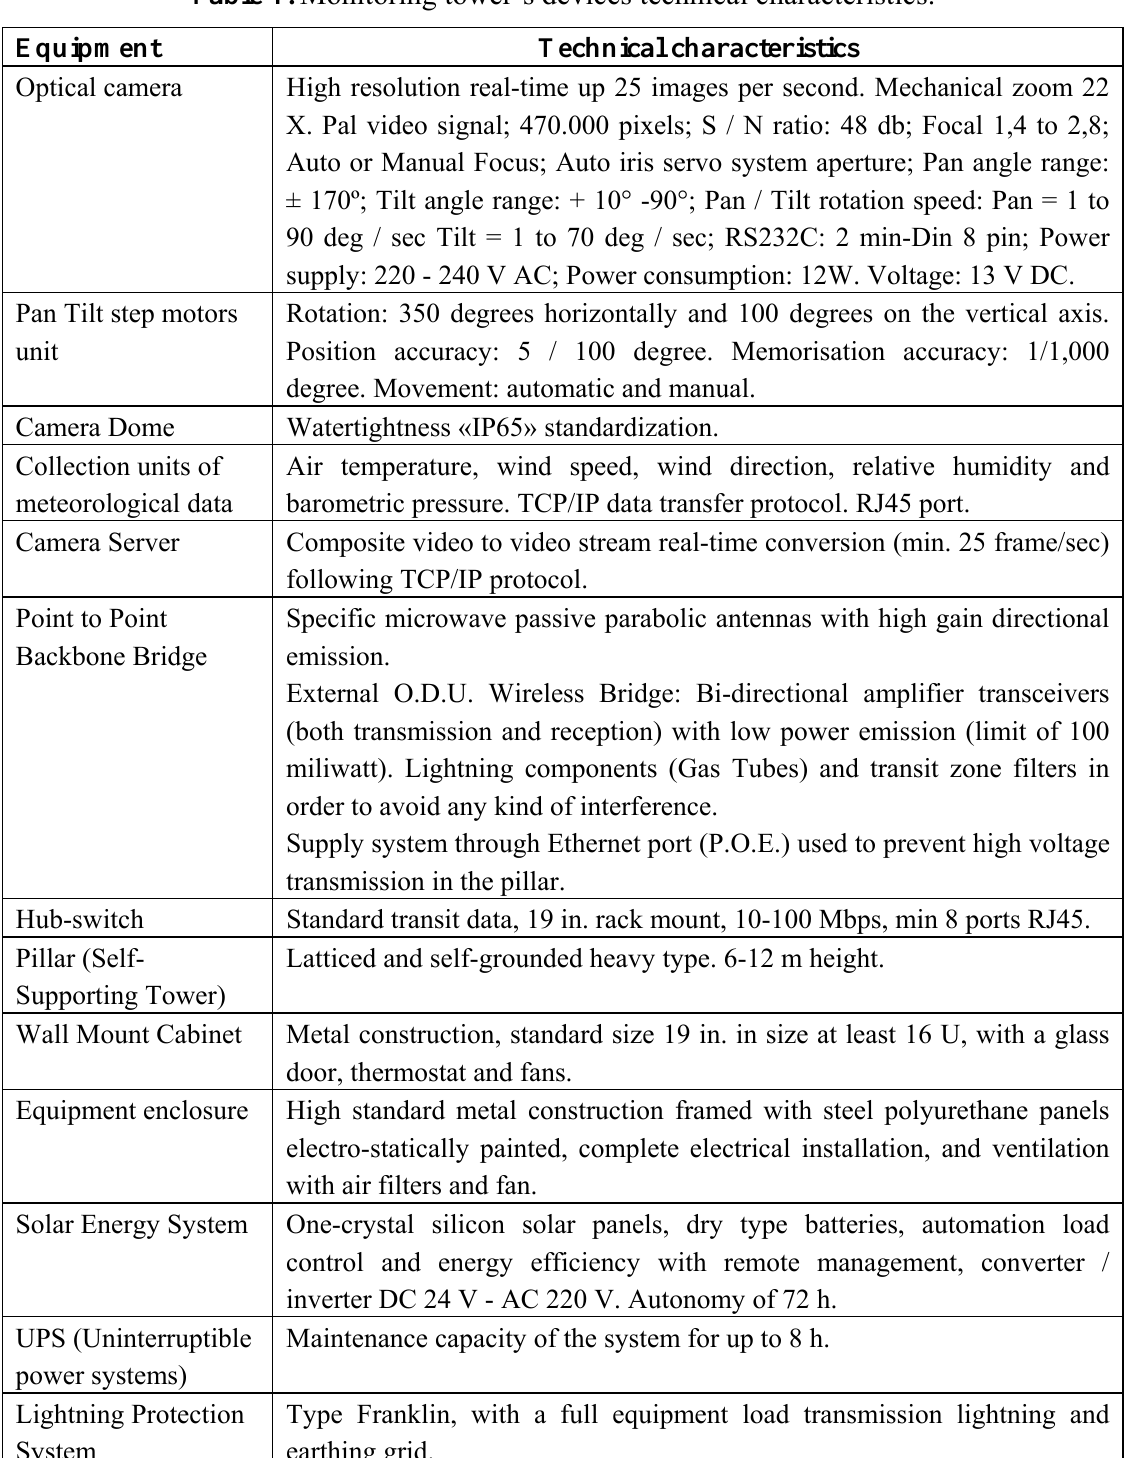
Table 1. Monitoring tower’s devices technical